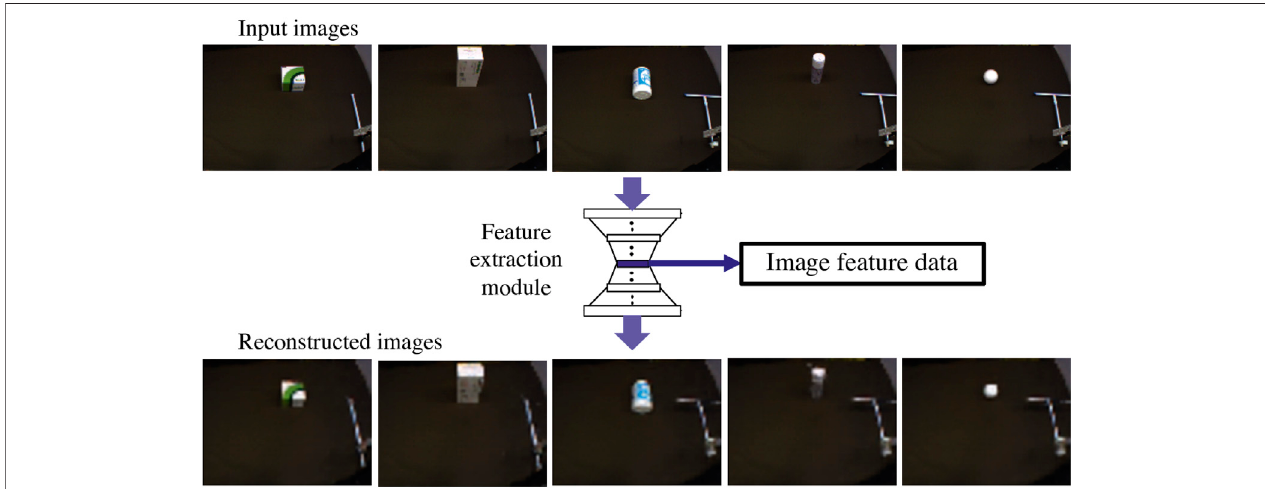
FIGURE 4 | Images reconstruction by the feature extraction module with the CAE. Upper images are original test data with training tools and objects, which are input to the module. The bottom images are reconstructed by the module. All images show their shape and size well, which demonstrates that the feature extraction module can well express image features in output from the center